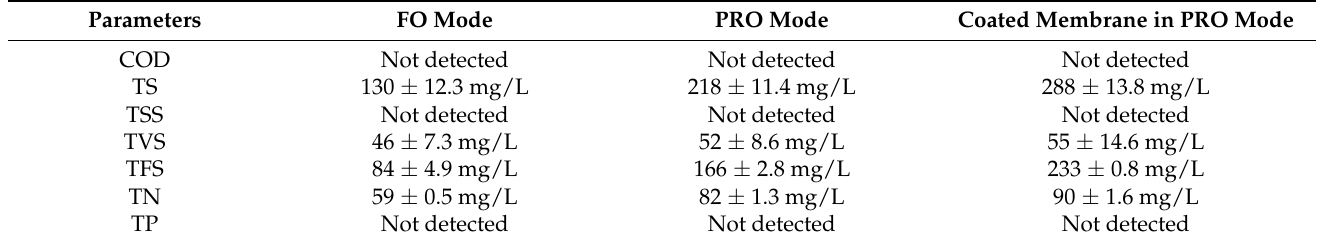
Table 7. FO permeate characterization for FO mode, PRO mode, and coated membrane in PRO mode.